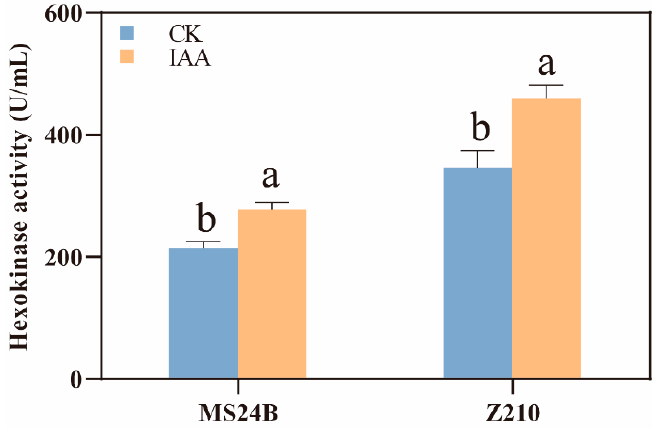
Figure 6. Effects of IAA treatment on hexokinase activity of sorghum mesocotyl. Lowercase letters indicate statistical differences ( p ≤ 0.05) among treatments.